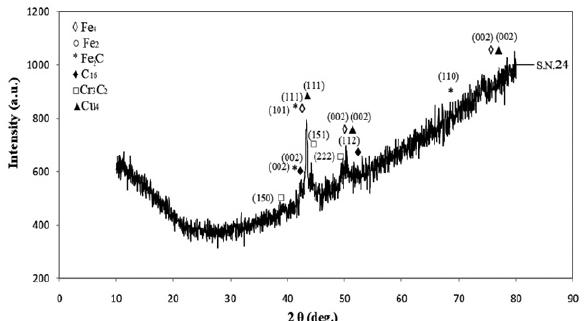
Figure 2. X-ray spectrum of the surface workpiece-24.